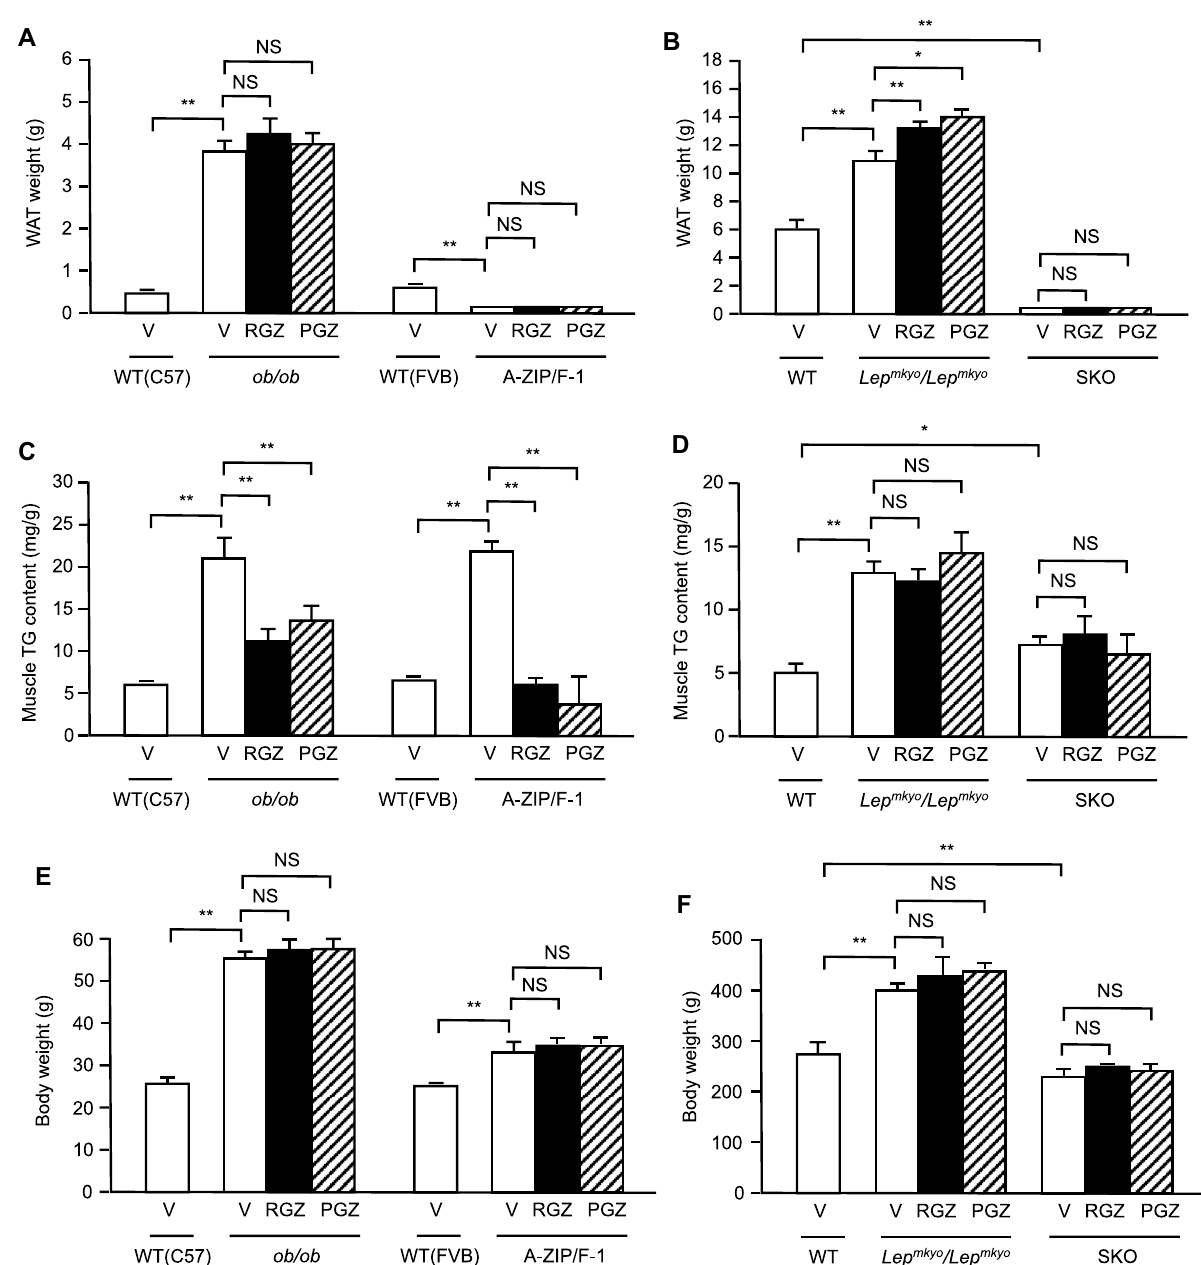
Figure 3. Effect of TZD treatment on WAT and skeletal muscle in mouse and rat models of leptin deficient obesity and generalized lipodystrophy. ( A , B ) epididymal WAT weight and ( C , D ) gastrocnemius muscle triglyceride content in C57B/6J WT, ob/ob , FVB/N WT and A-ZIP/F-1 mice ( A , C ) and F344 WT, Lep mkyo / Lep mkyo and SKO rats ( B , D ) treated with vehicle, RGZ or PGZ. Values are means ± SEM ( n = 10 per group). * P < 0.05, ** P < 0.01, NS, not significant (one-way ANOVA followed by Tukey’s test). ND, not